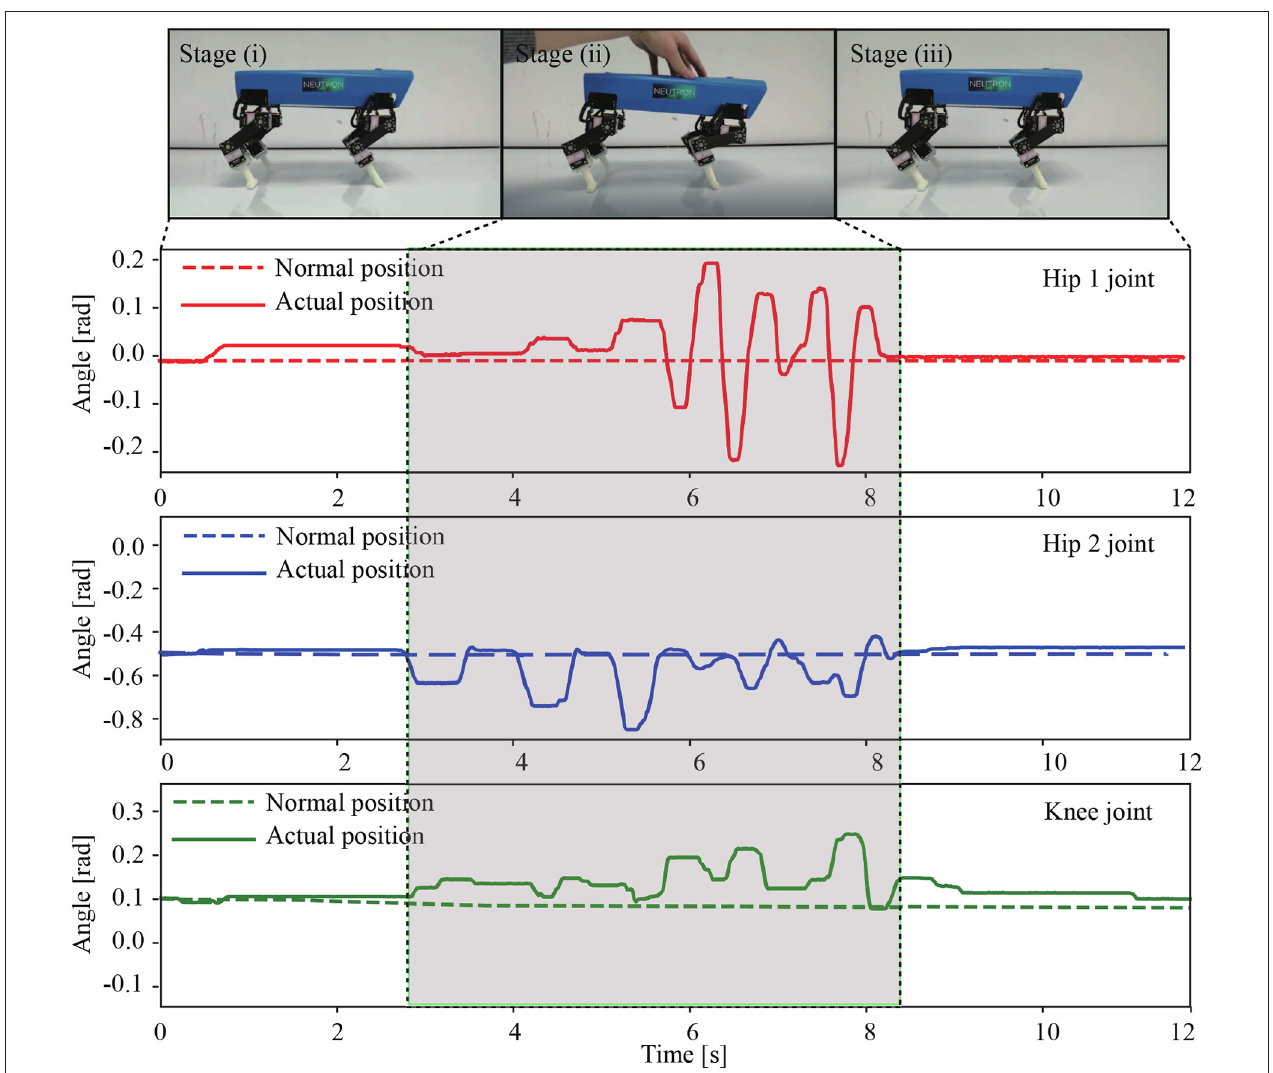
FIGURE 10 | Compliant behavior of Lilibot and angle feedback of the hip 1, hip 2, and knee joints of the RF leg. The normal positions of joints were the desired positions of compliant control. The robot was placed on the ground and was stooding in the initial stage (i). In stage (ii), a hand was used to apply a force on its body, and the robot exhibited compliance to compensate for the perturbation. During stage (iii), the robot returned to its normal position after the load was